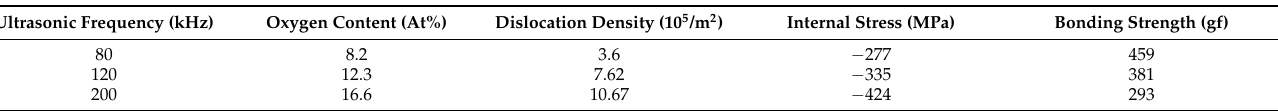
Table 2. Results of the oxygen content, the internal stress, the dislocation density and the bonding strength under different ultrasound frequencies.